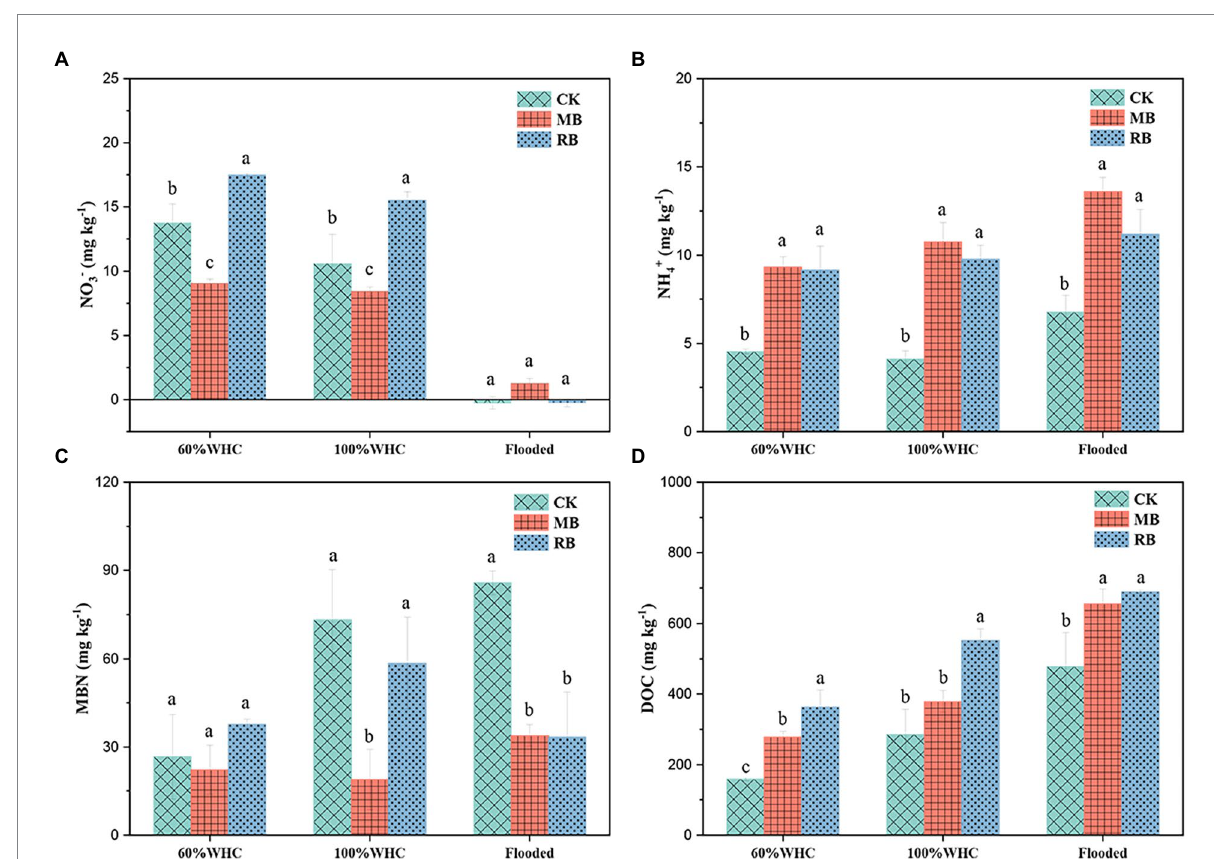
FIGURE 4 Contents of soil NO 3 − (A) , NH 4+ (B) , microbial biomass nitrogen (MBN; C ), and dissolved organic carbon (DOC; D ) with biochar amendments on the first day after thawing. (CK: control; MB: maize straw biochar; RB: rice straw biochar; a and b indicate significant differences among the different biochar treatments, p < 0.05; error bars represent the standard error, n =